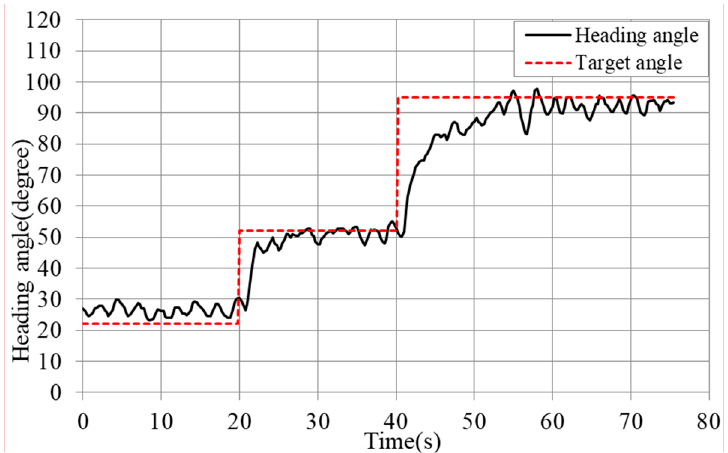
Figure 11. Experiment with multiheading control. The horizontal axis is time (s). The vertical axis is the heading degree. The black line is the heading angle of the ROV. The red dash line is the target angle.